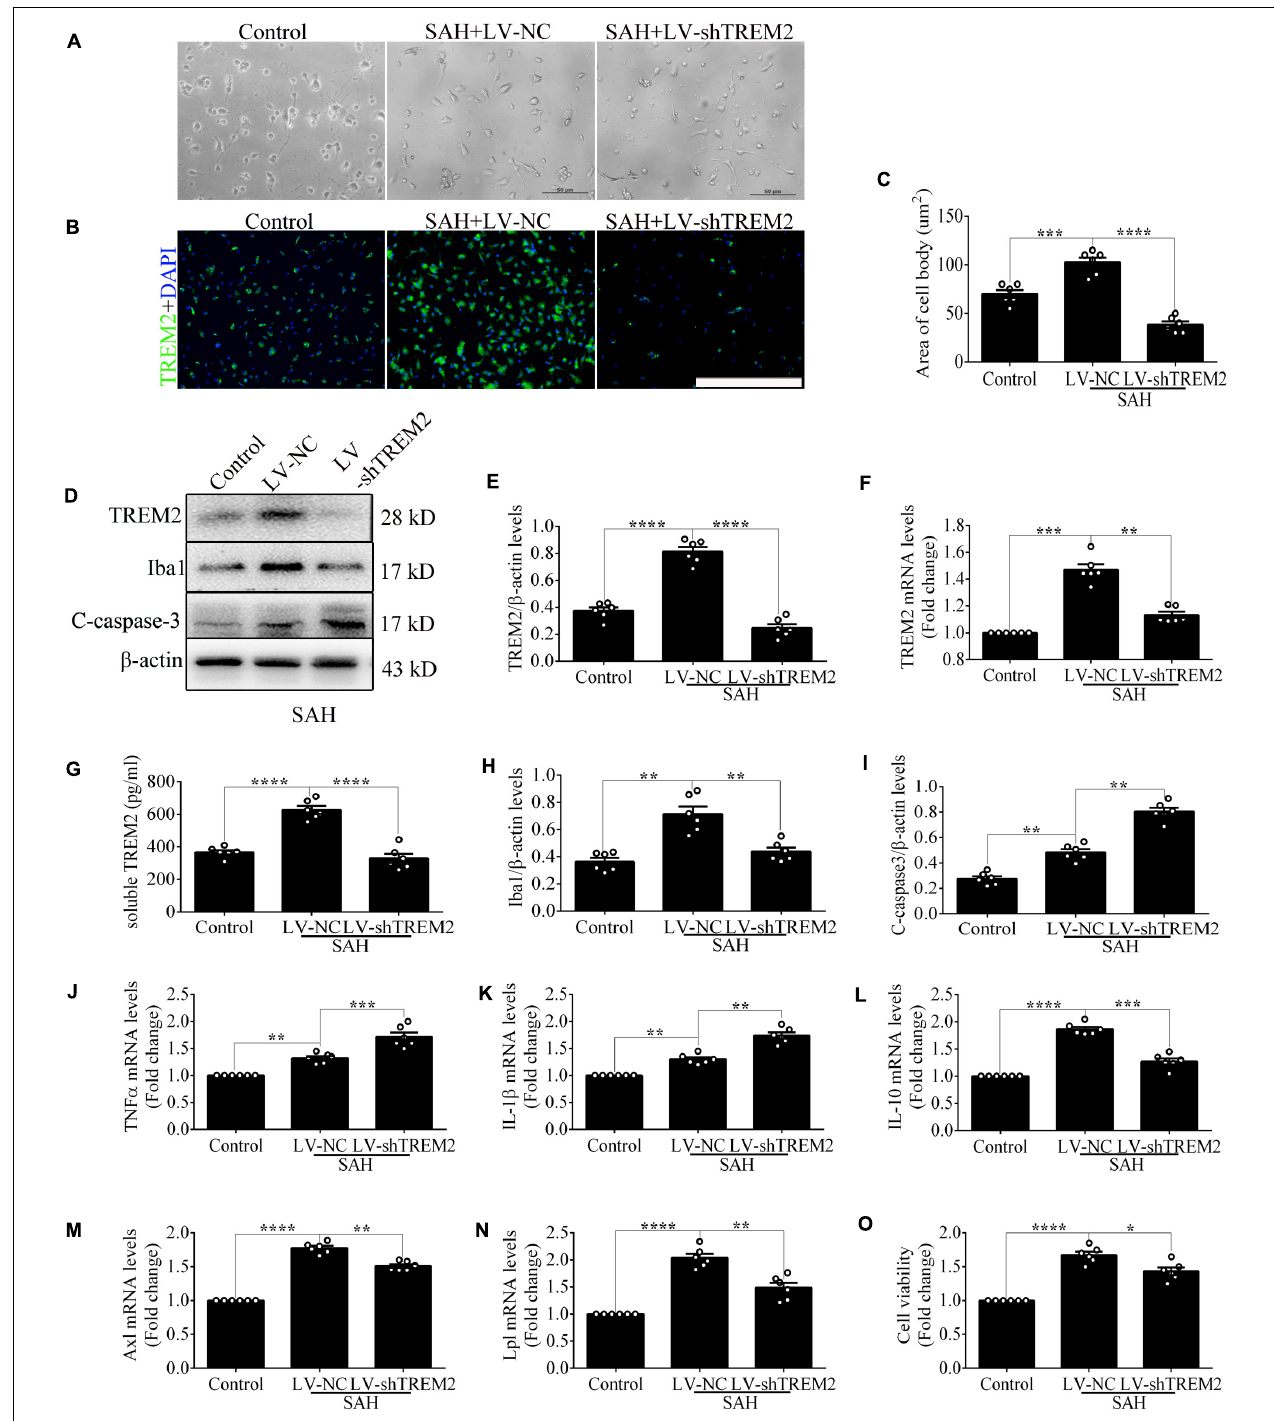
FIGURE 2 | Triggering receptor expressed on myeloid cells 2 ( TREM2 ) silencing modulates microglial polarization at 12 h after subarachnoid hemorrhage (SAH). (A) Higher-magnification images showed the morphological change of primary microglia in vitro . (B,C) Immunofluorescence staining and quantitative analysis of the knockdown efficiency of TREM2 in vitro . (D–I) Representative Western blot bands and quantification of TREM2 , soluble TREM2 , TREM2 mRNA, ionized calcium-binding adaptor molecule 1(Iba1), cleaved caspase-3, and β -actin. (J–N) Quantitative real-time PCR detection revealed the relative mRNA levels of M2 phenotype mRNA [interleukin (IL)-10], M1 phenotype mRNA [tumor necrosis factor (TNF) α and IL-1 β ], phagocytic gene (Axl), and lipid metabolism-related gene (Lpl). (O) The changes of microglial viabilities were determined by TREM2 knockdown. These data are shown as mean ± SEM (* p < 0.05, ** p < 0.01, ***p < 0.001, **** p < 0.001; scale bar = 50 µ